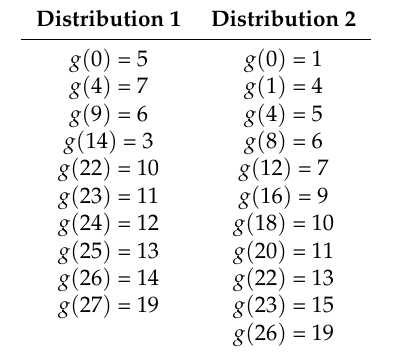
Table 1. Two distributions of the threshold number of individuals for switching from action B to action